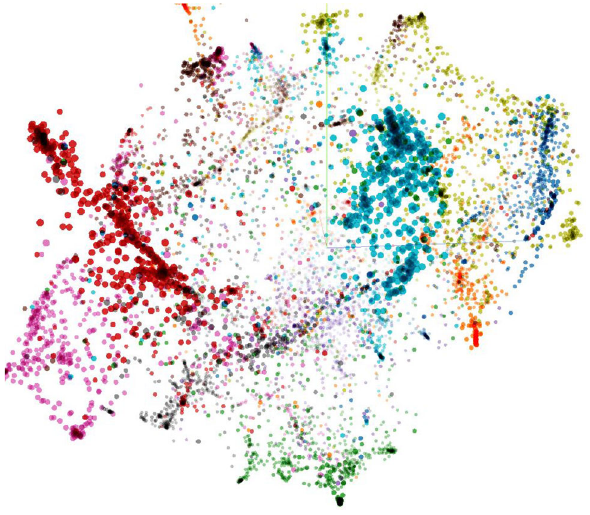
Fig. 1 Subtask partitioning (best viewed in color). Each point repre- sents an image and the associated color is a one of the n b = 10 clusters. For dimensionality reduction (from R 2560 to 3D), we used t-SNE